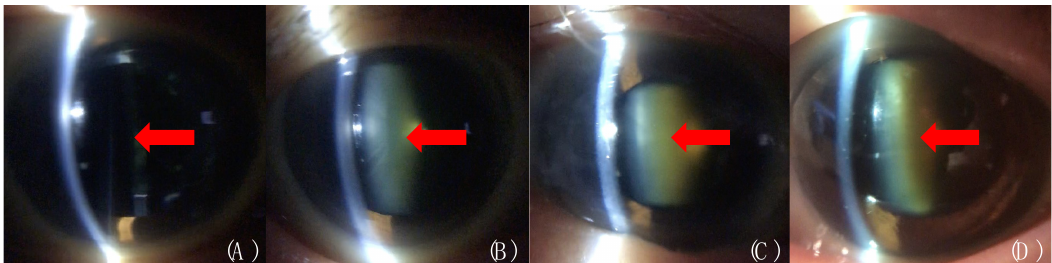
Figure 3. Representative cases imaged with the Smart Eye Camera. Eyes with ( A ) the lens replaced by an intraocular lens (IOL), ( B ) NUC grade 1, ( C ) NUC grade 2, and ( D ) NUC grade 3 are shown. Each red arrow indicates IOL or NUC.